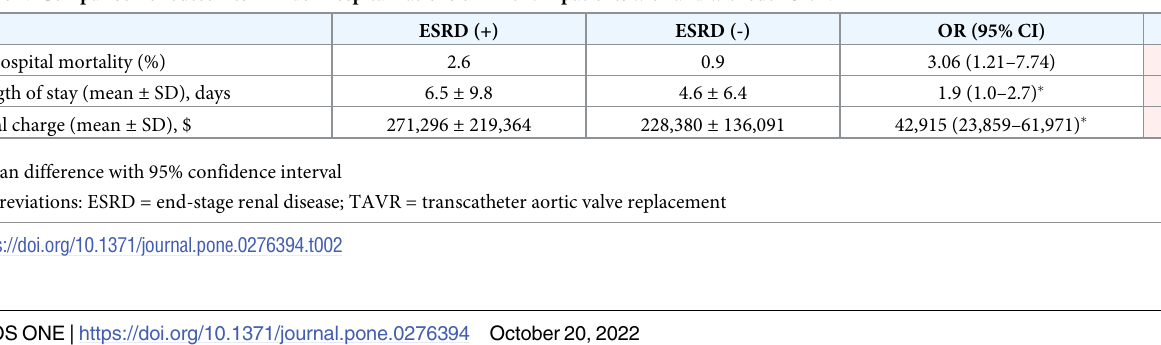
Table 2. Comparison of outcomes in index hospitalizations of TAVR in patients with and without